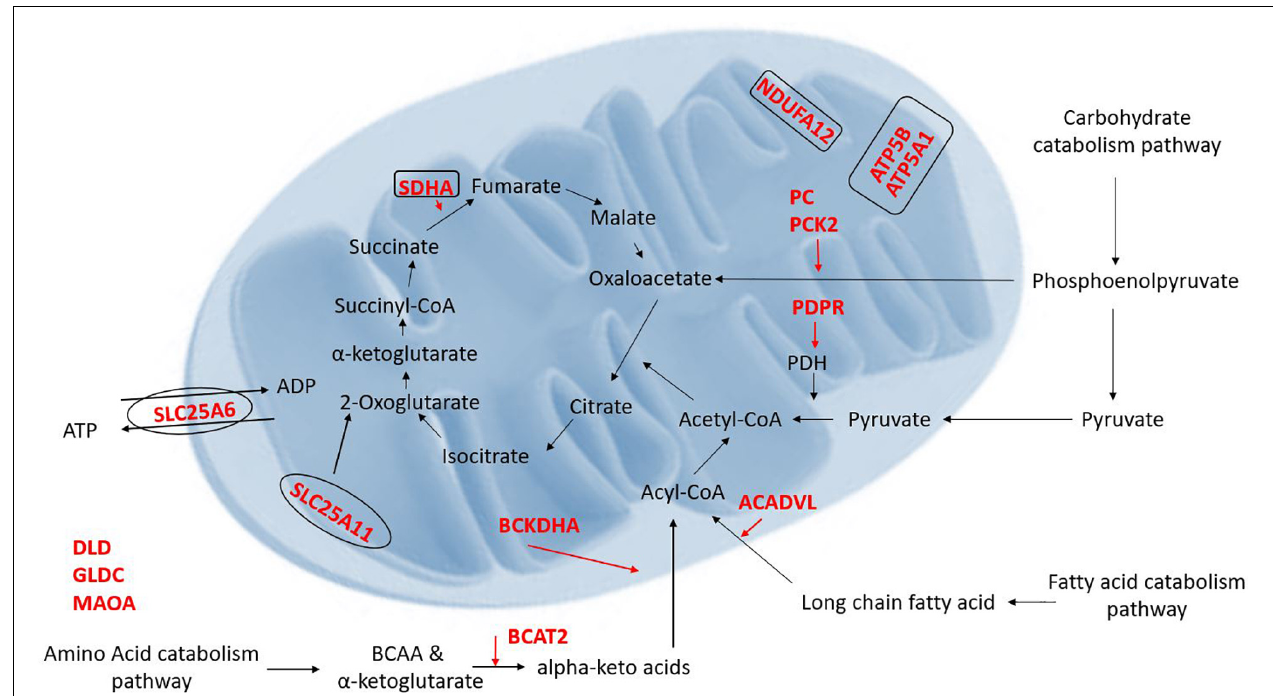
FIGURE 2 | Illustration of the proteins which were found to be decreased (red) in the Syncytio-Mito compared to Cyto-Mito in this study and their implication in mitochondrial function and metabolism (rectangle illustrates mitochondrial complexes, ovals illustrate